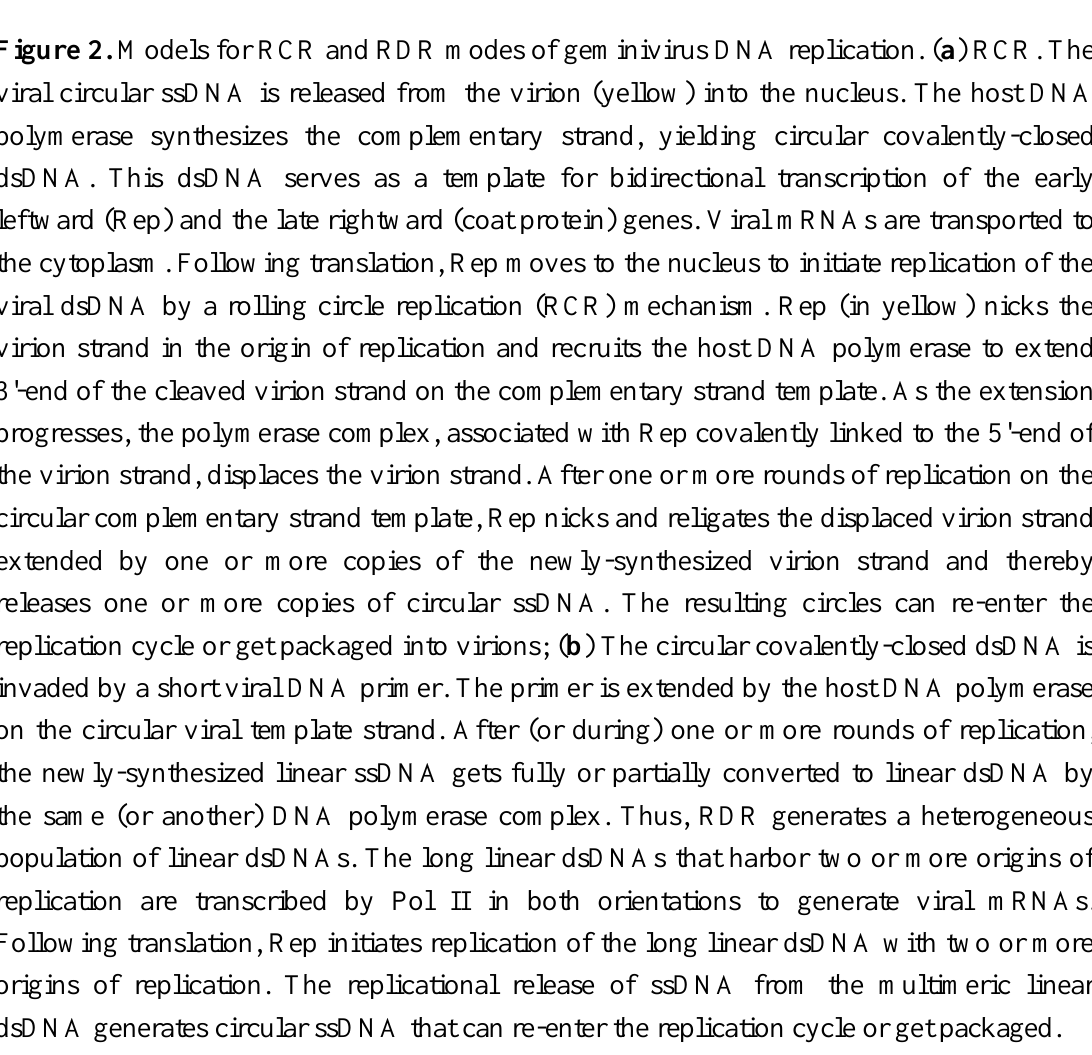
Figure 2. Models for RCR and RDR modes of geminivirus DNA replication. ( a ) RCR. The viral circular ssDNA is released from the virion (yellow) into the nucleus. The host DNA polymerase synthesizes the complementary strand, yielding circular covalently-closed dsDNA. This dsDNA serves as a template for bidirectional transcription of the early leftward (Rep) and the late rightward (coat protein) genes. Viral mRNAs are transported